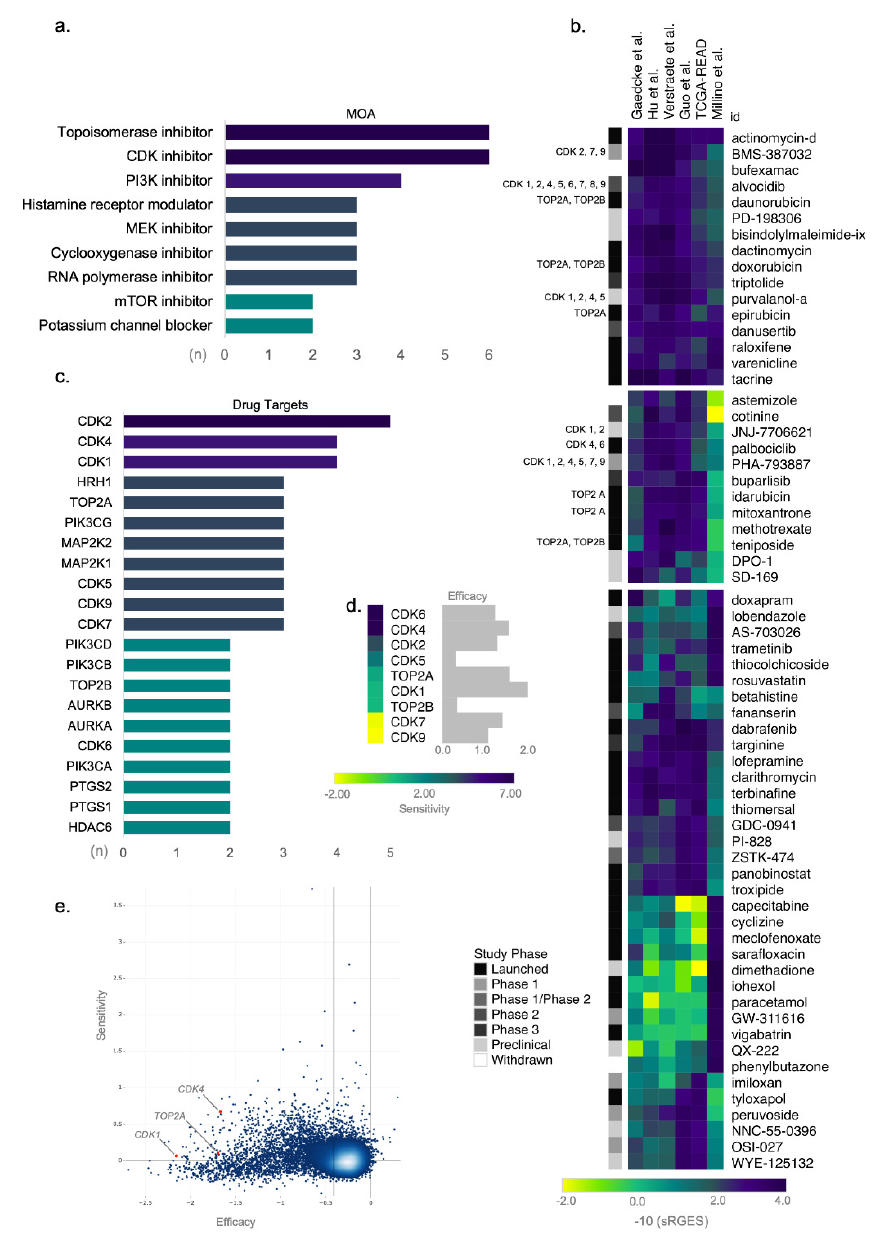
Figure 3. Topoisomerase and cyclin-dependent kinase (CDK) inhibitors as candidate targets for drug repositioning in rectal cancer (ReCa). ( a ) Drugs sharing similar mechanism of action (MOA) included among the top 100 compounds with the highest summarized Reversal Gene Expression Score (sRGES) determined by Open Cancer TherApeutic Discovery (OCTAD; http://octad.org) (accessed on 5 May 2021). ( b ) Heatmap of representative scores of overall reversal potency of a compound (sRGES) to ReCa signatures. The sRGES were clustered by the k-means clustering algorithm, and only the three clusters with the highest sRGES were displayed in the heatmap. The clinical phase of the drug development process for each compound is indicated in grayscale on the left side of the heatmap. Compounds targeting CDK and topoisomerase inhibitors are in the same two clusters with the highest sRGES. CDK1, CDK2, CDK4, CDK5, CDK6, CDK7, CDK8, and CDK9 genes are indicated by 1, 2, 4, 5, 6, 7, 8, and 9, respectively. ReCa signatures are clustered by Euclidean distance between sRGES. ( c ) Drug targets for the top 100 compounds with the highest drug reversal potency score determined by OCTAD. We included only drug targets sharing the same specific target in the graph. ( d ) To predict the efficacy and selectivity of candidate drugs, the growth reduction caused by the loss of function of the CDK1, CDK2, CDK4, CDK5, CDK6, CDK7, CDK8, CDK9, TOP2A , and TOP2B genes (efficacy), and the selectivity of this effect across all cancer cell lines available at Cancer